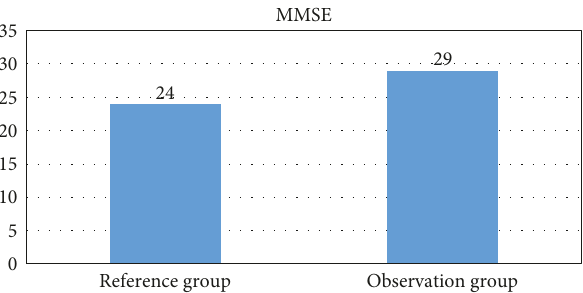
Figure 4: Visualization of the MMSE score results. Table 4: Comparison of treatment effectiveness (%).